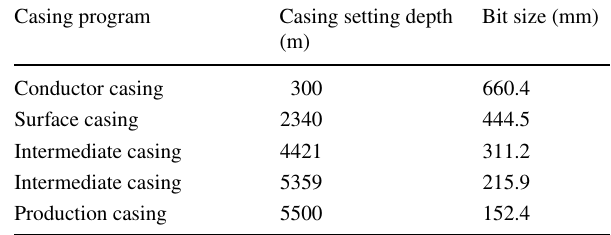
Table 5 Comparison of glycol mud and oil-based mud Well No. Mud Type Interval